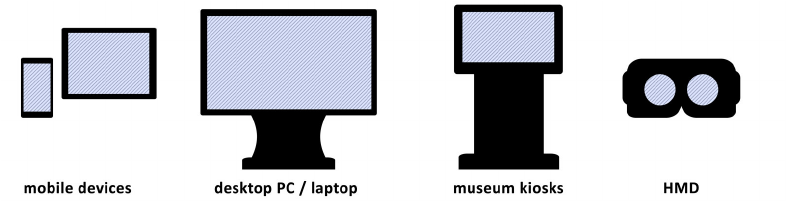
Figure 7. Device classes to consume ATON